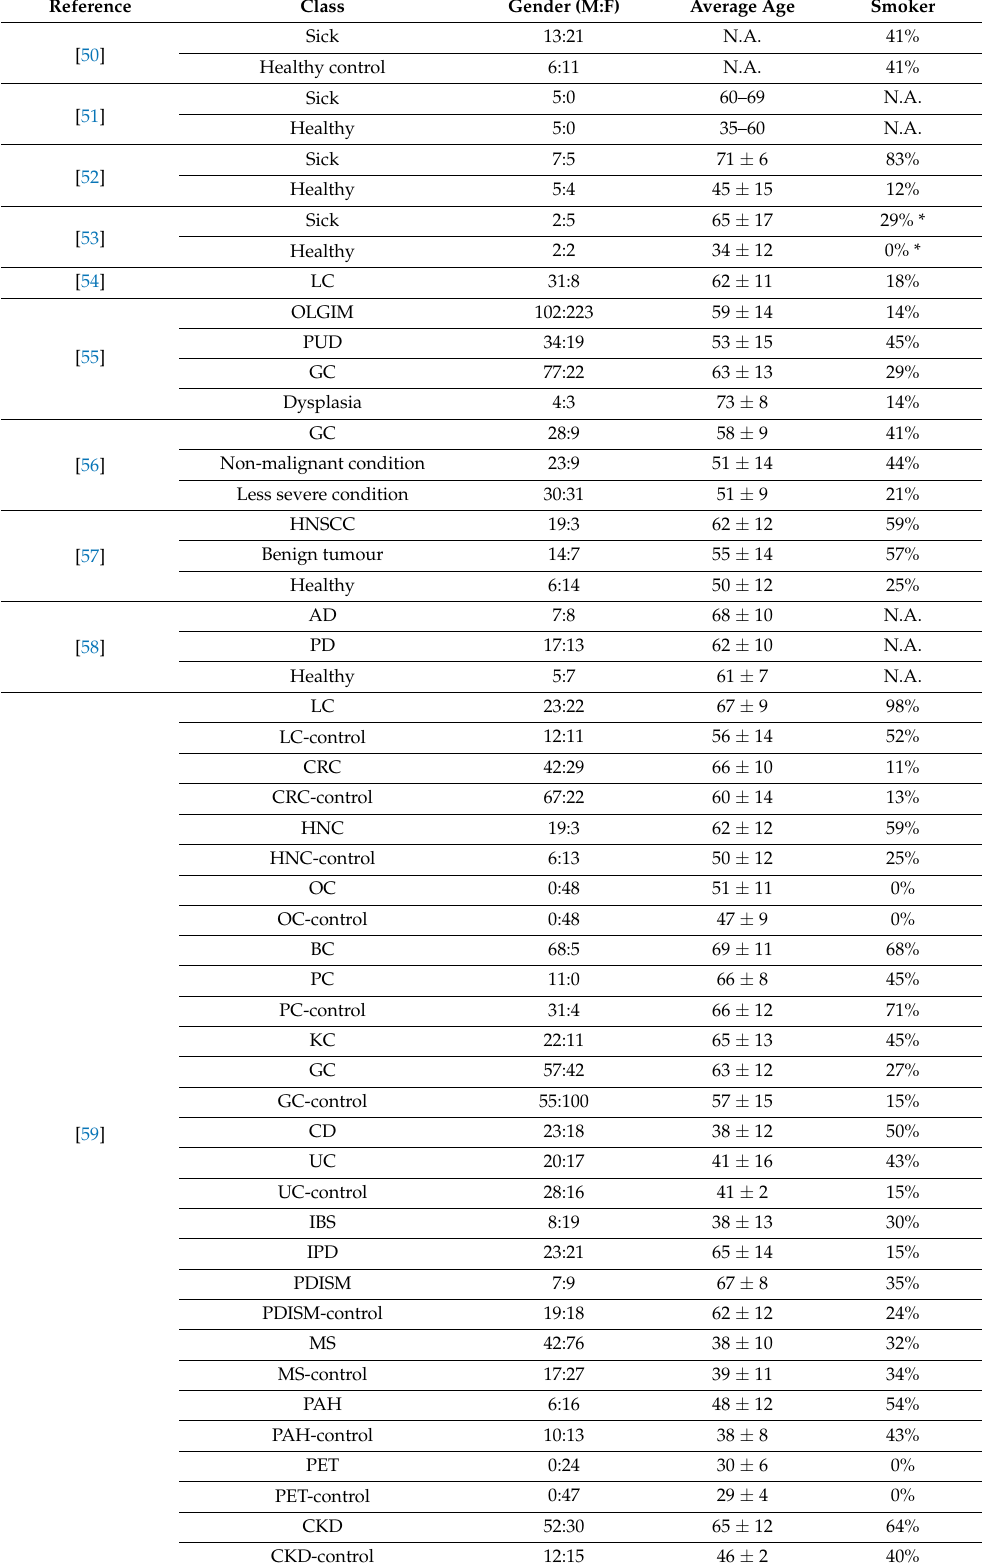
Table 2. Gender, average age and smoking habits of the volunteers enrolled in each study. N.A. = data not available. * Data reported in